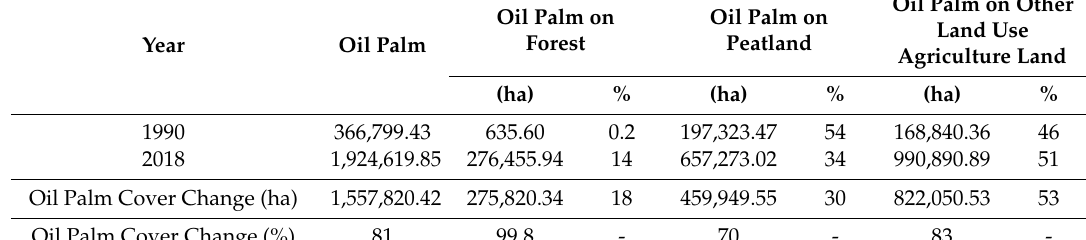
Table 7. Amount of oil palm cover in Sarawak (1990 and 2018).